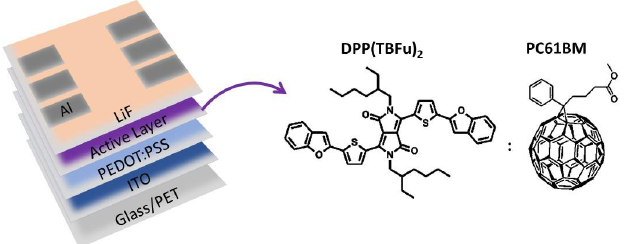
Figure 1. Chemical structures of the active layer compounds DPP(TBFu) 2 and PC 61 BM and schematic representation of the device structure used in this work.